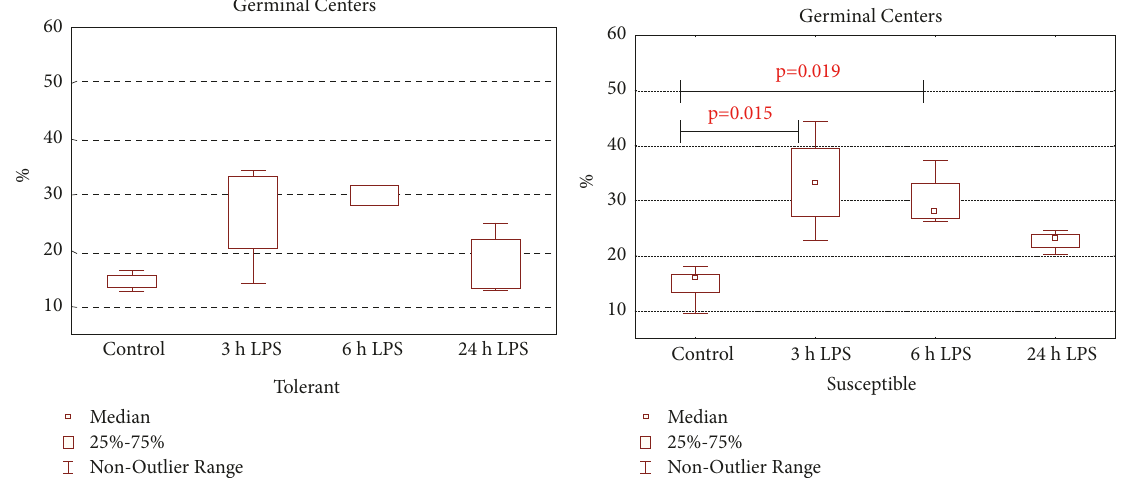
Figure 6: The volume fraction of germinal centers of spleen lymphoid follicles in tolerant- and susceptible-to-hypoxia rats after 3, 6, and 24 hours of LPS administration. Data are presented as median (25%, 75%); the statistical significance of differences ( p ) is determined by the Kruskal-Wallis method ( 𝑛 = 5 in each group).